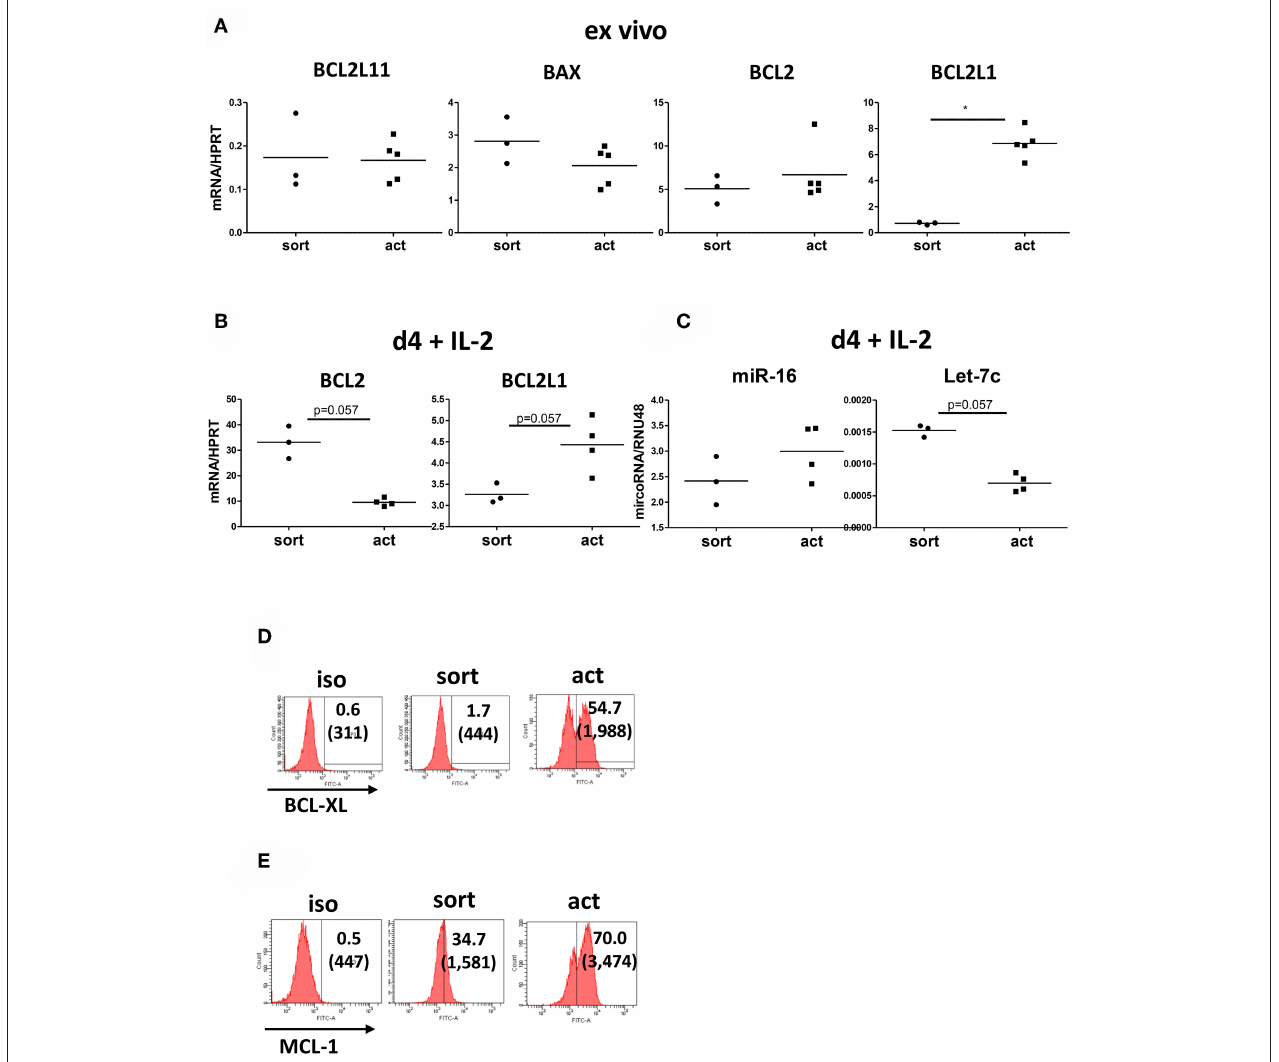
FIGURE 6 | Transiently activated Treg upregulate BCL2L1 ( BCL-XL ) expression. (A) Real-time PCR analysis of expression of genes encoding pro-apototic [ BAX , BCL2L11 ( BIM) ] and anti-apoptotic [ BCL2 , BCL2L1 (BCL-XL) ] proteins in freshly isolated and transiently activated (15h) Tregs. n = 3–5, data normalized to HPRT . (B) Real-time PCR analysis of BCL2 and BCL2L1 ( BCL-XL ) expression, normalized to HPRT , from day 4 cultures of unstimulated and 15h transiently activated Tregs incubated with IL-2. (C) Real-time PCR analysis of miR-16 and Let-7c microRNA expression, normalized to RNU48, from cultures described in (B) . n = 3–4 donors, groups were compared using a non-parametric Mann-Whitney U -test, * p < 0.05. Additionally, levels of (D) BCL-XL and (E) MCL-1 were measured by FACS. Histograms from one representative donor are shown. * p <